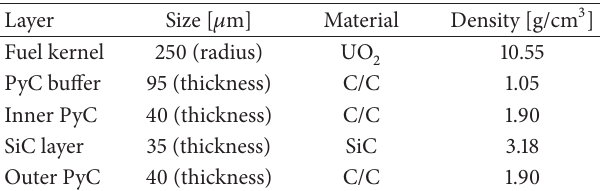
Table 2: Characteristics of a TRISO particle [31].